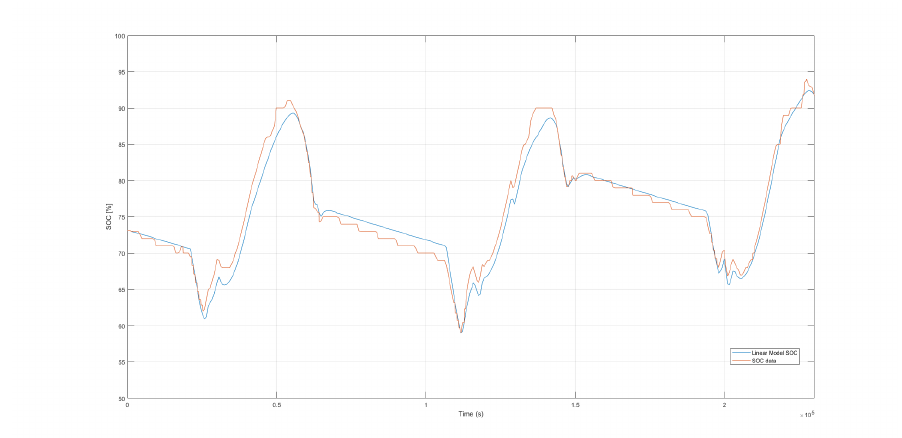
Figure 6. Comparison of computed battery SOC (orange) and actual data of the SOC (blue).